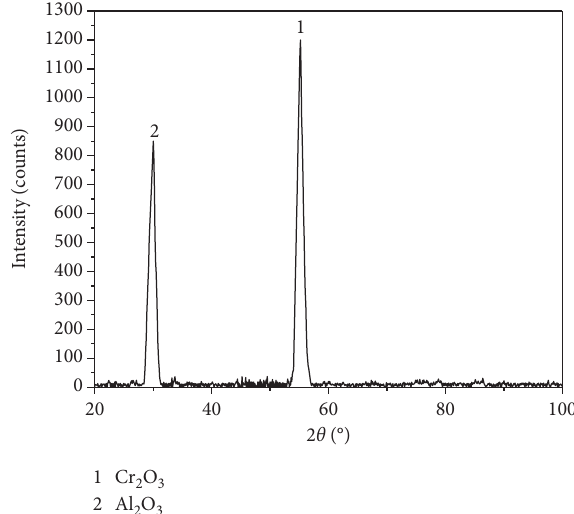
Figure 4: XRD pattern of the surface oxide film of NiCoCrAlY coating oxidized at 1050 ° C for 100h.